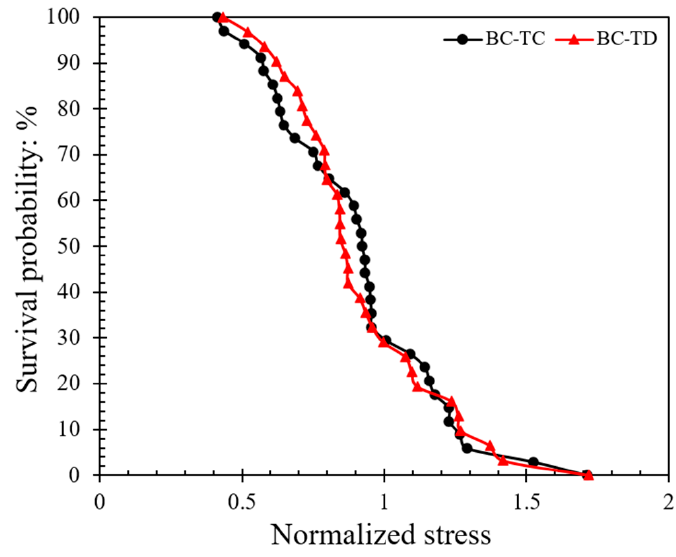
Figure 17. Comparison between different system failure modes on the survival probability for loading rate 0.01 mm/min.